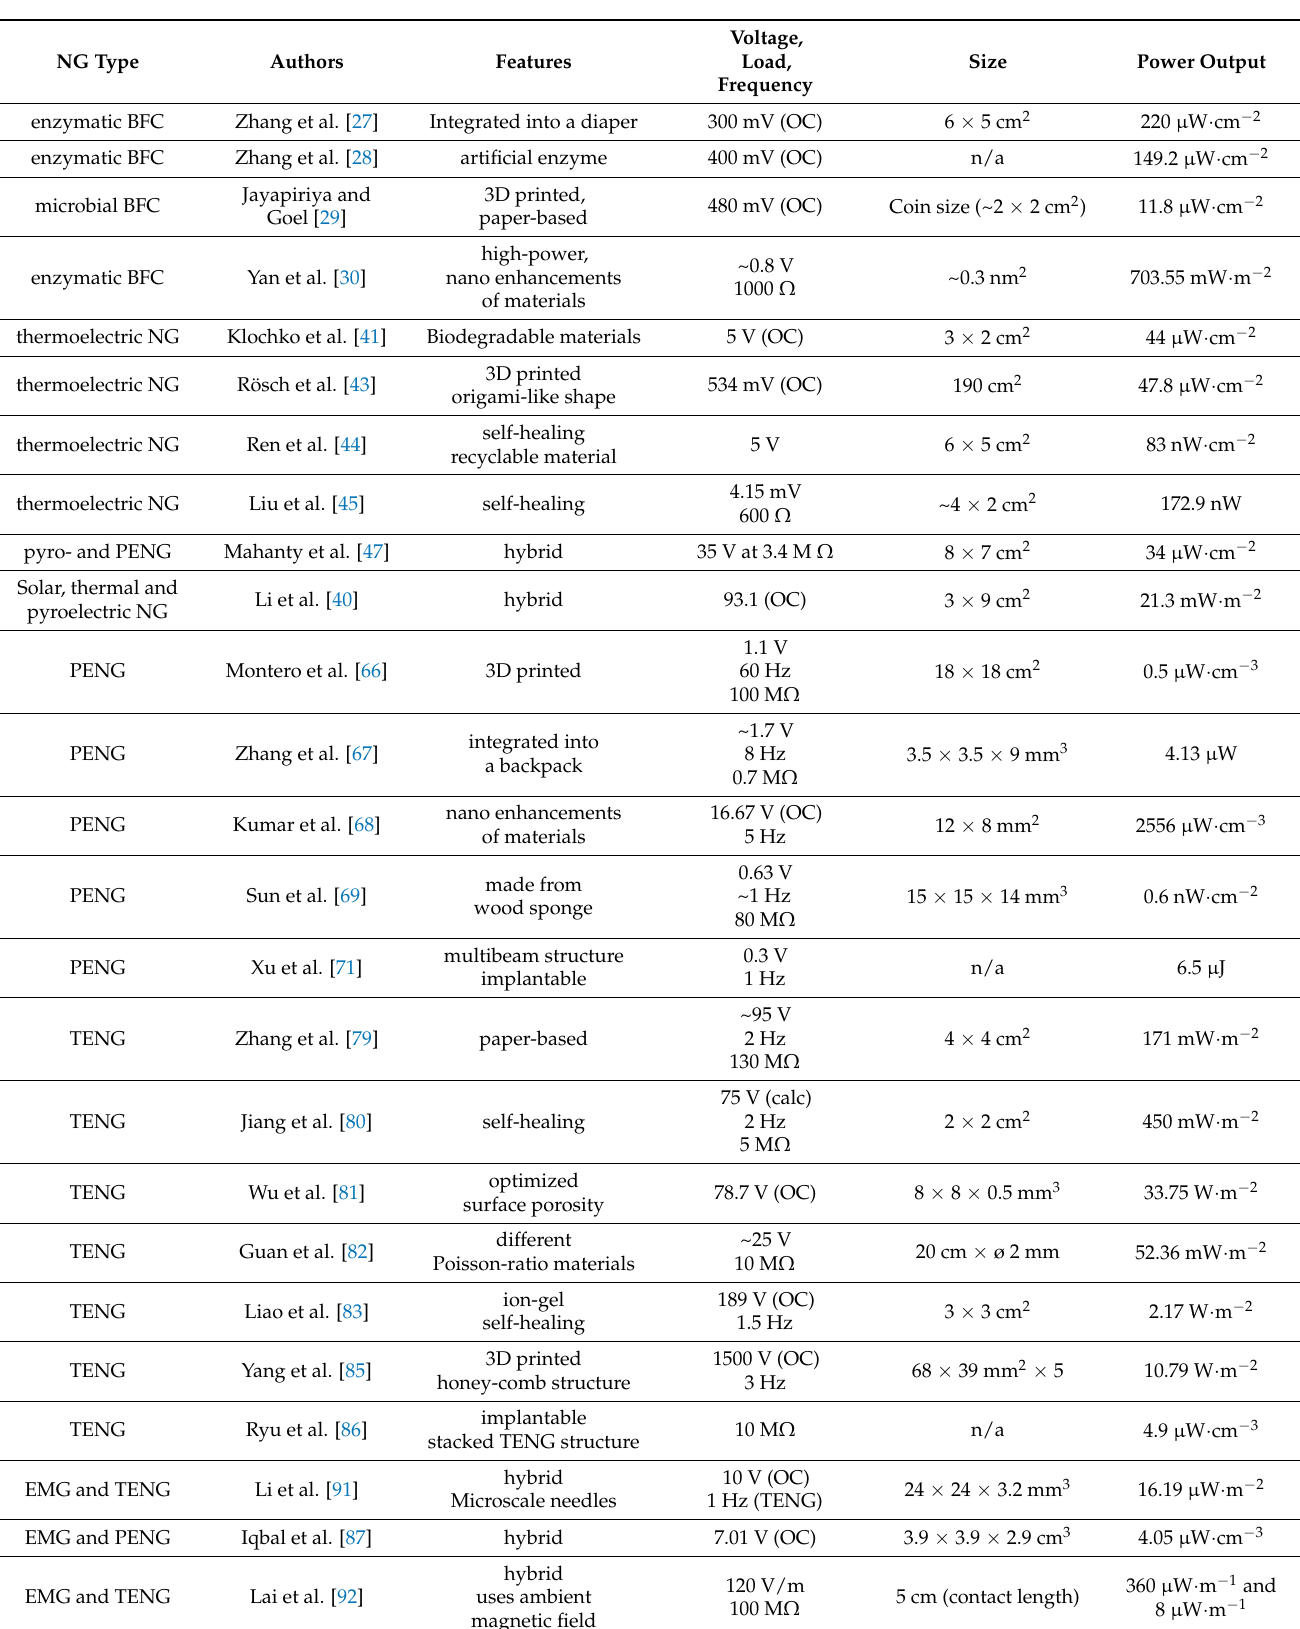
Table 1. Comparison of